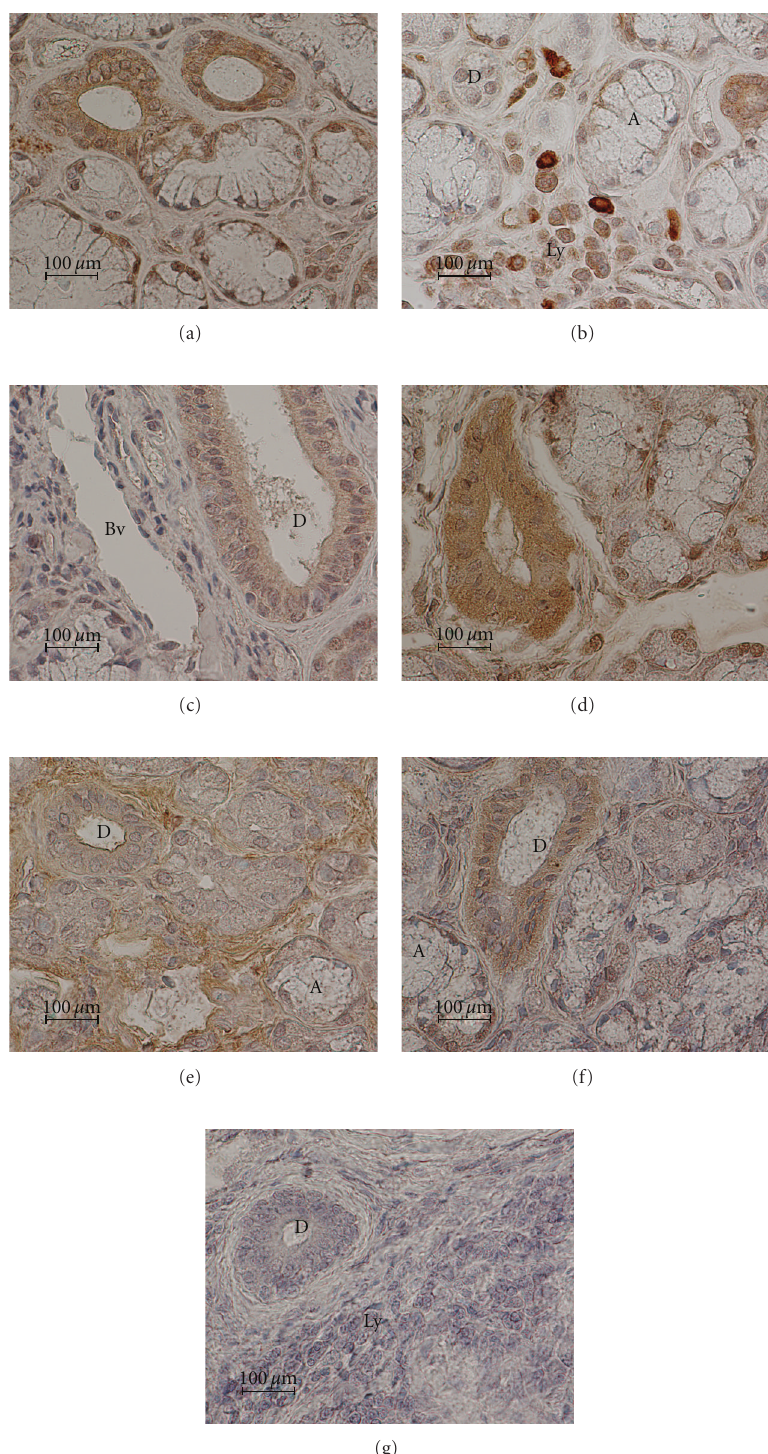
Figure 2: Expression of IL-23 and IL-23R in minor salivary glands of patients with pSS, probable preclinical pSS and nonautoimmune sicca syndrome. IL-23: (a) pSS, (b) probable preclinical pSS, (c) nonautoimmune sicca syndrome. IL-23R: (d) pSS, (e) probable preclinical pSS, (f) nonautoimmune sicca syndrome, (g) negative staining control. Counterstained with hematoxylin. Original magnification × 400. Abbreviations: A: acinus, Bv: blood vessel, D: ductus, and Ly: lymphocyte